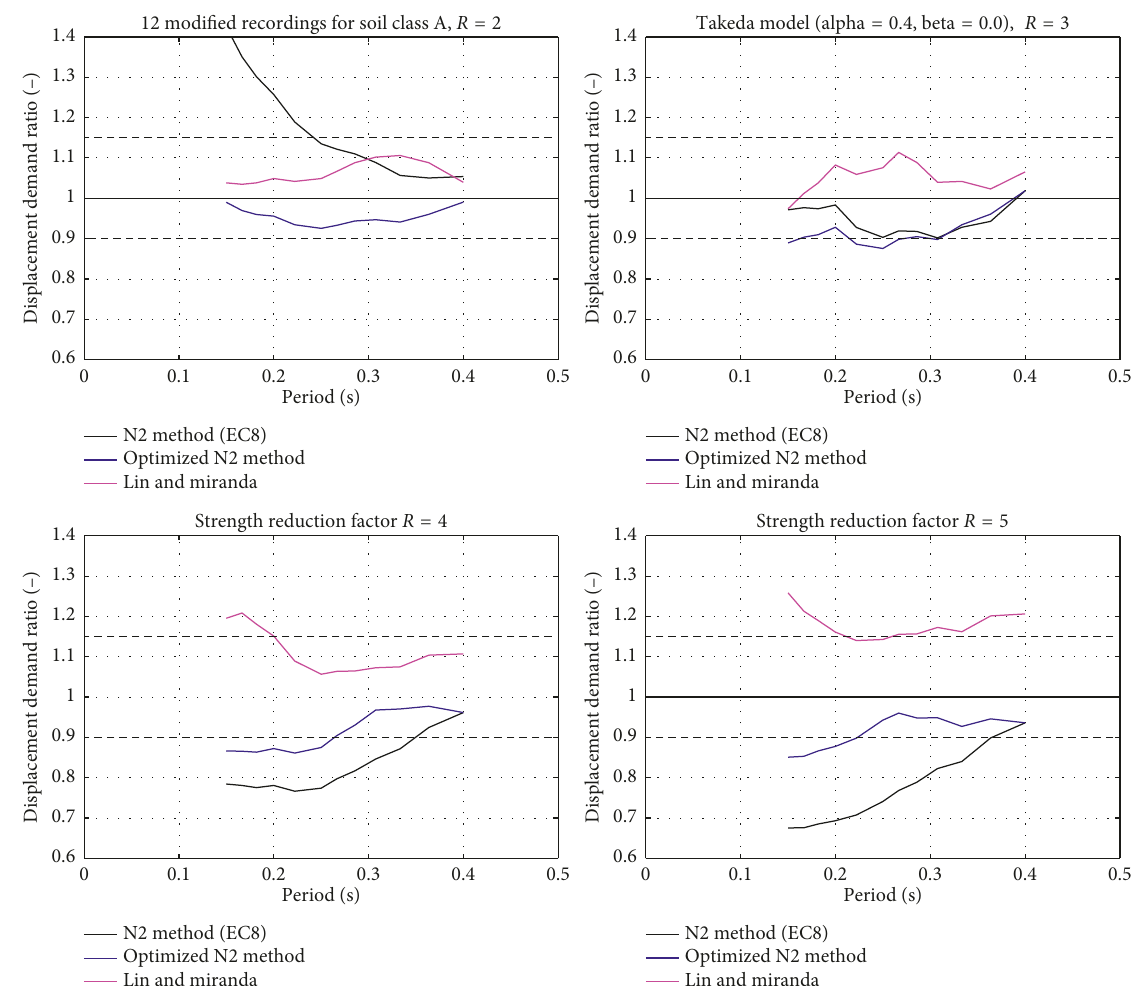
Figure 8: Assessment of the nonlinear displacement demands for soil class A and four values of strength reduction factors, R The ratio of predicted to actual (NLTHA) displacement demand is plotted with respect to the period. The plateau period range of the corresponding response spectrum (0.15s to 0.40s) is considered for the